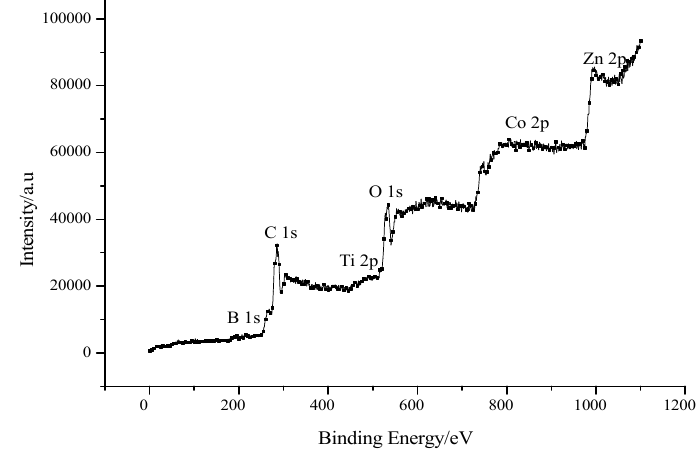
Figure 9. XPS image of Co-B codoped TiO 2 /ZnO film.